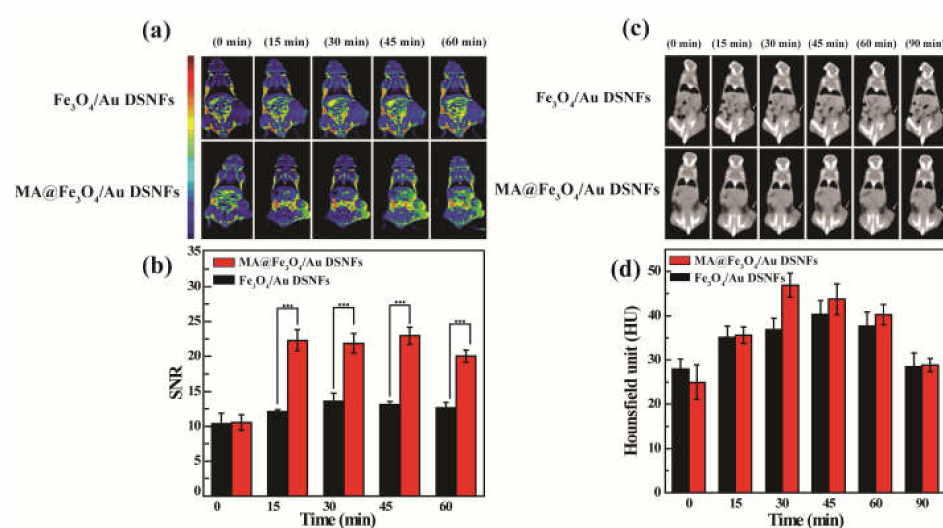
Figure 5. In vivo tumor MR and CT imaging. ( a ) In vivo T 1 -weighted MR images and ( b ) the corresponding MR SNR of the 4T1 tumor anterior to injection and at diverse time points post- injection of Fe 3 O 4 /Au DSNFs and MA@Fe 3 O 4 /Au DSNFs ([Fe] = 100 µ g, in 0.2 mL PBS for every mouse), separately (mean ± S.D., n = 3). The MR signal intensity of blank (air) was utilized as the background (noise). TE = 12 ms, TR = 377 ms, and ST = 2.0. ( c ) CT images and ( d ) corresponding CT values of the 4T1 cancer in ICR mice before and at diverse time points post intravenous injection of the Fe 3 O 4 /Au DSNFs and MA@Fe 3 O 4 /Au DSNFs ([Au] = 0.04 M, in 200 µ L PBS for every